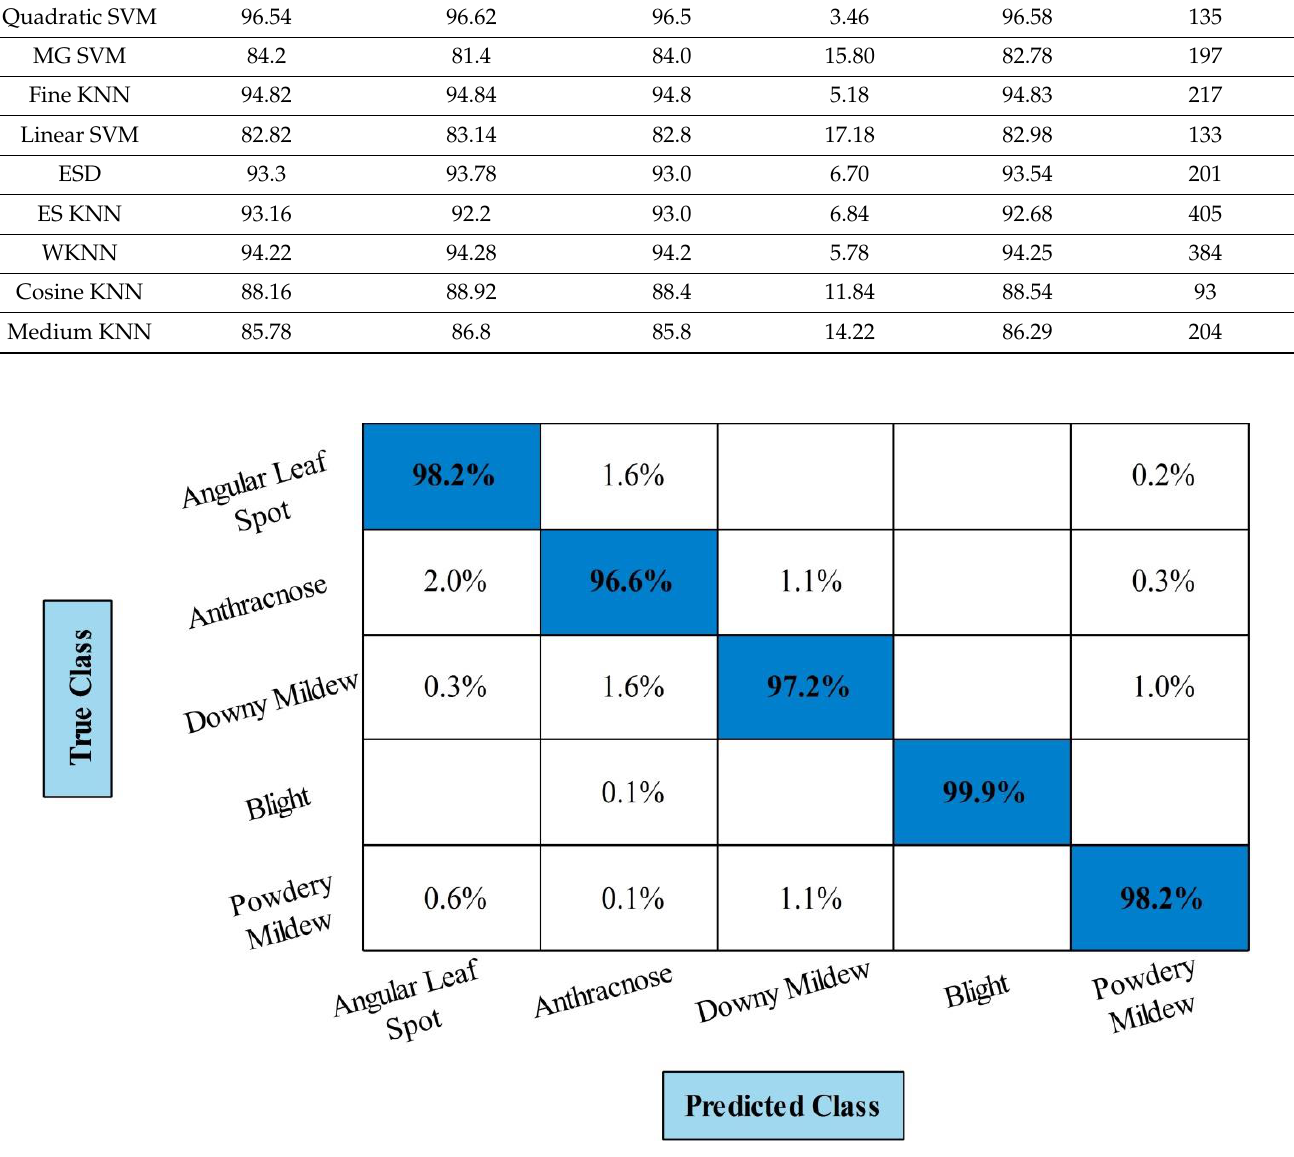
Figure 6. Comparison of all experiments in terms of testing time. After the selection of the best dense features, in the next step all fine-tuned deep model features are fused using the proposed parallel approach. The results of this ex- periment are given in Table 8. The best-noted accuracy in this table is 98.2% on Cubic SVM. The recall and precision rates are 97.92 and 98.12%, respectively. Figure 7 illus- trated the confusion matrix that can be utilized for the verification of the recall rate. The time of each classifier is also noted and plotted in Figure 6 (Fusion Entropy-ELM). In comparison with the results of Tables 6 and 7, it is noted that the overall accuracy is im- proved but the time is more increased than in the Dense Entropy-ELM step.